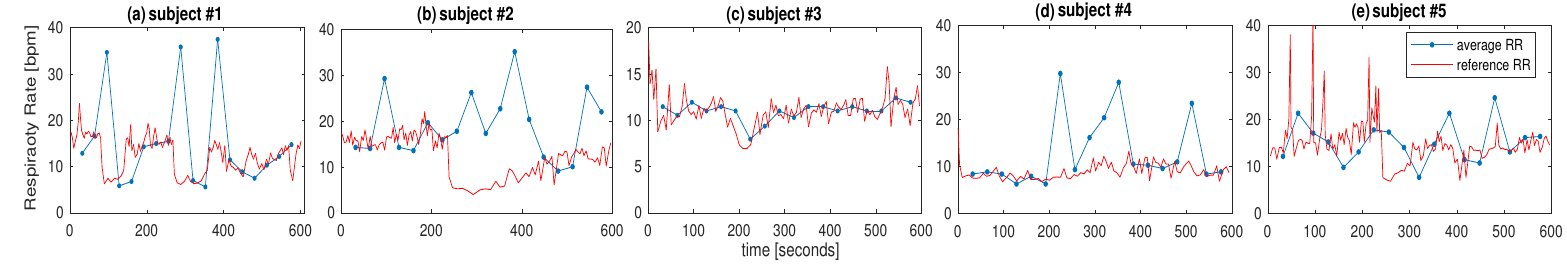
Figure 11. Estimated average instantaneous respiratory rate using the AR-spectral based method for five subjects wearing the Wavelethealth sensor. Fewer number points (18 or 19) have been obtained using windows of 32 s long. There is a mis-agreement for many segments: ( a ) subject #1; ( b ) subject #2; ( c ) subject #3; ( d ) subject #4; ( e ) subject